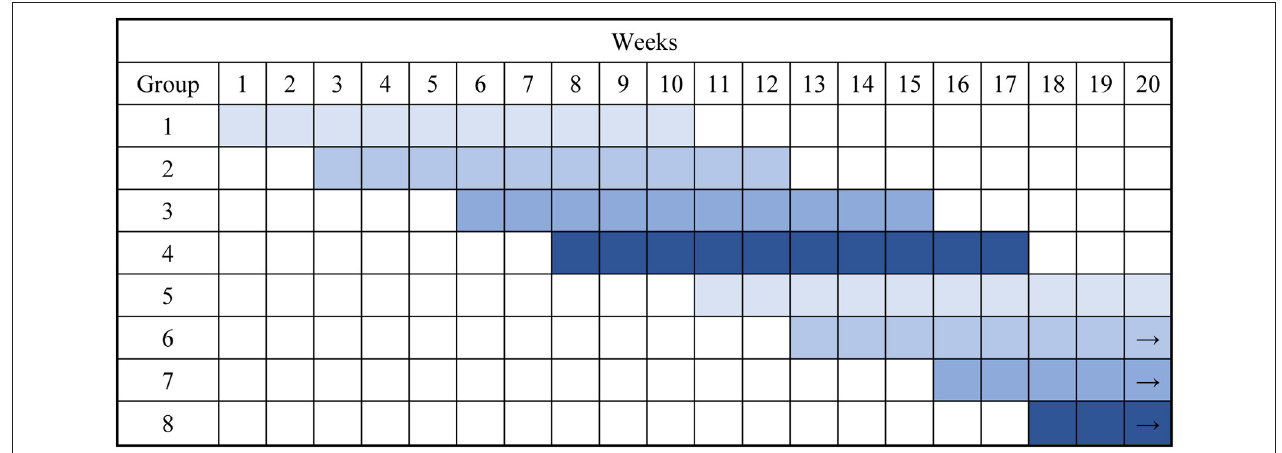
FIGURE 1 | Example of the flow of children at the health camps with four groups at the time.